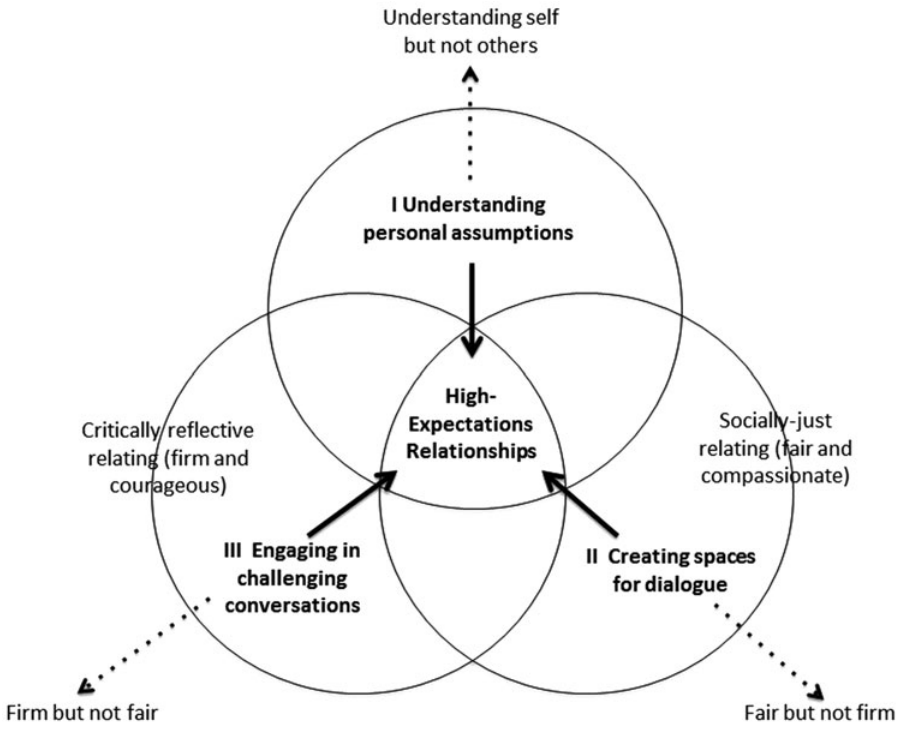
FIGURE 2 The high-expectations relationships relational